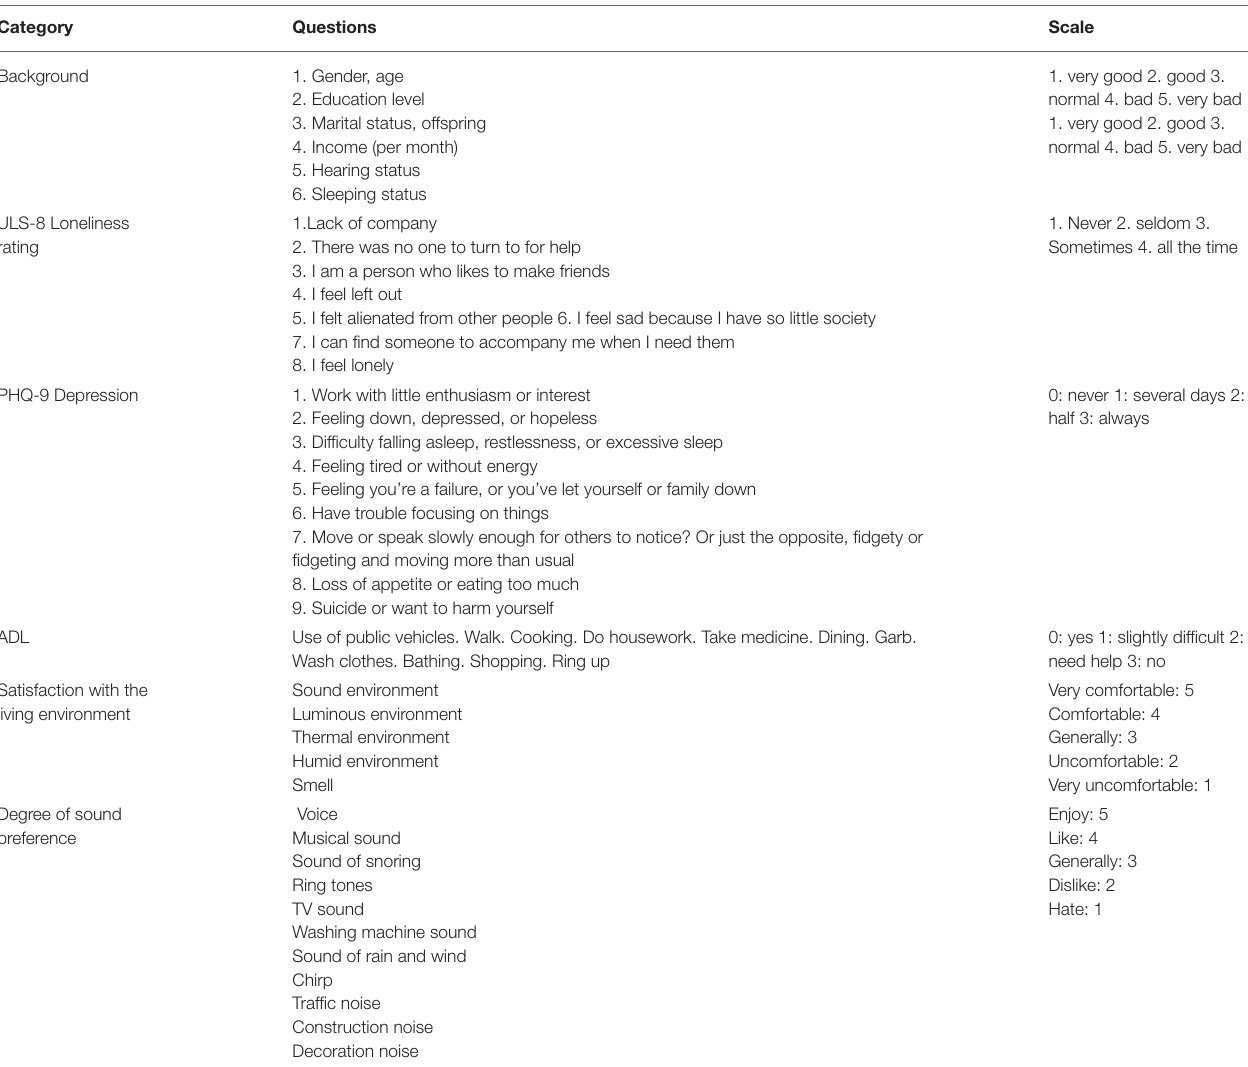
TABLE 1 | The content of the questionnaire. Category Questions Scale